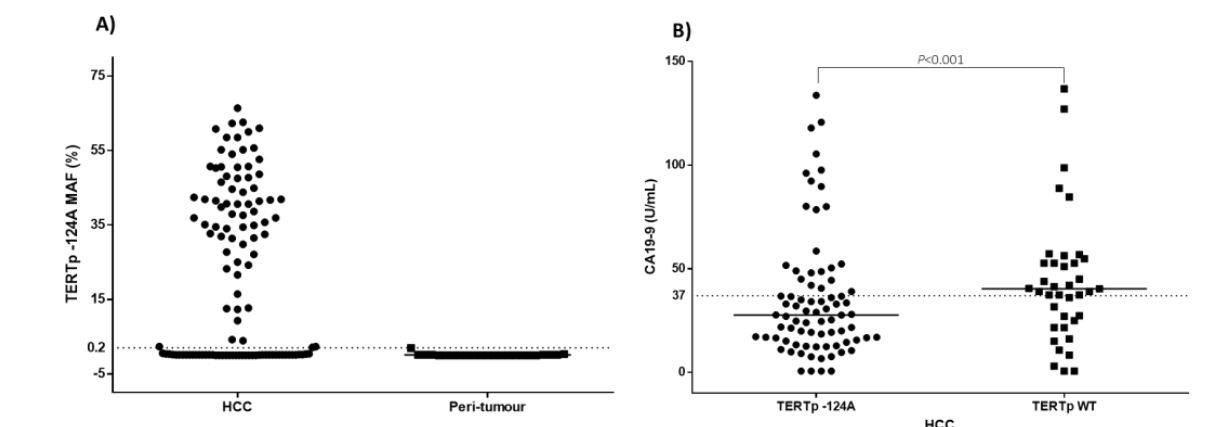
Figure 2. ( A ) Mutation allele frequency (MAF, %) of TERTp − 124A in HCC and peri-tumour tissues. Black dashed line indicates the lower limit of detection of TERTp − 124A assay. ( B ) CA19-9 levels in HCC patients with TERTp wildtype (WT) and TERTp − 124A. The black dashed line indicates the upper limit of CA19-9 reference intervals. The black line indicates the mean value in each group.